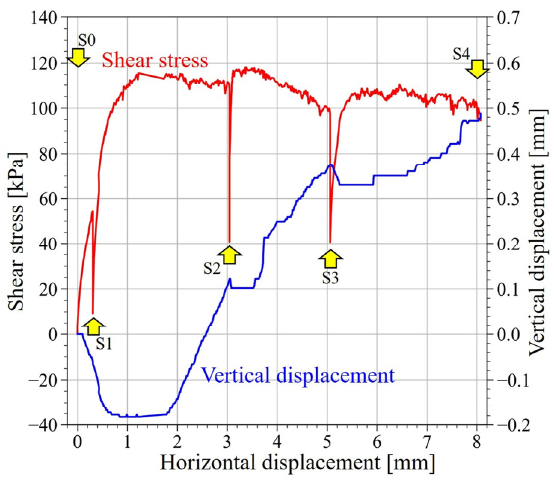
Figure 7. Experimental results of direct shear experiment. CT scanning was performed when hor- izontal displacement was 0.0 (S0), 0.3 (S1), 3.0 (S2), 5.0 (S3), and 8.0 mm (S4). horizontal displacement was 0.0 (S0), 0.3 (S1), 3.0 (S2), 5.0 (S3), and 8.0 mm